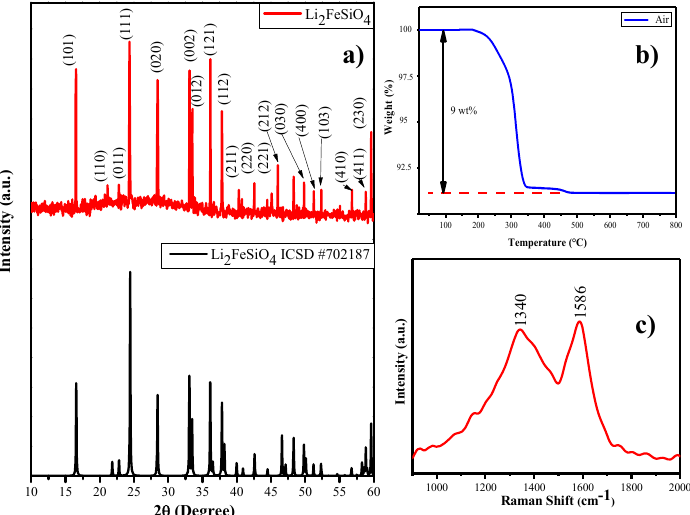
Figure 2. ( a ) XRD pattern, ( b ) thermogravimetric (TG) curve, and ( c ) Raman spectrum of the as-prepared